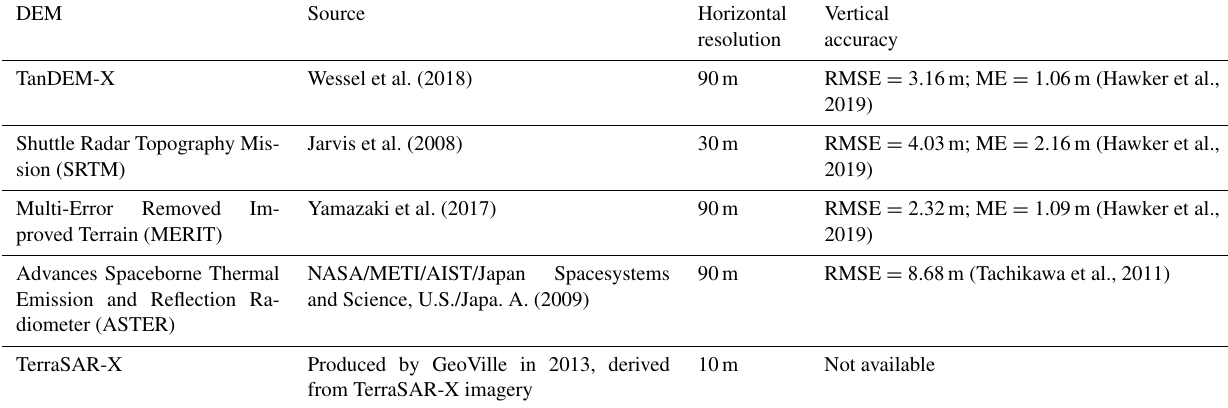
Table 3. Overview of investigated globally available satellite DEMs: TanDEM-X, SRTM, MERIT, ASTER and TerraSAR-X. Horizontal resolution and global error metrics of RMSE and mean error (ME) for the vertical accuracy are also provided.